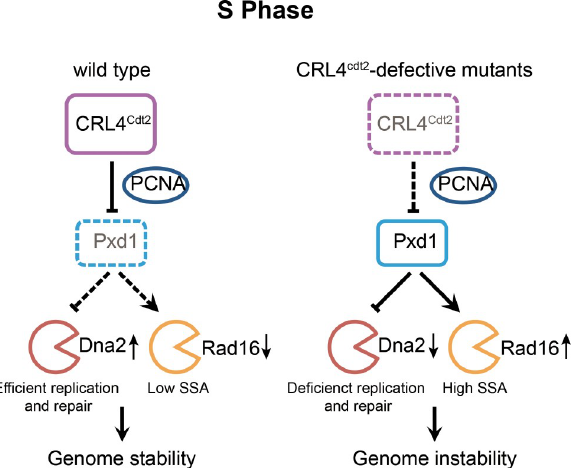
Fig 7. Model explaining how CRL4 Cdt2 ubiquitin ligase promotes genome stability by regulating the activities of Dna2 and Rad16 through PCNA-dependent degradation of Pxd1 in S phase.